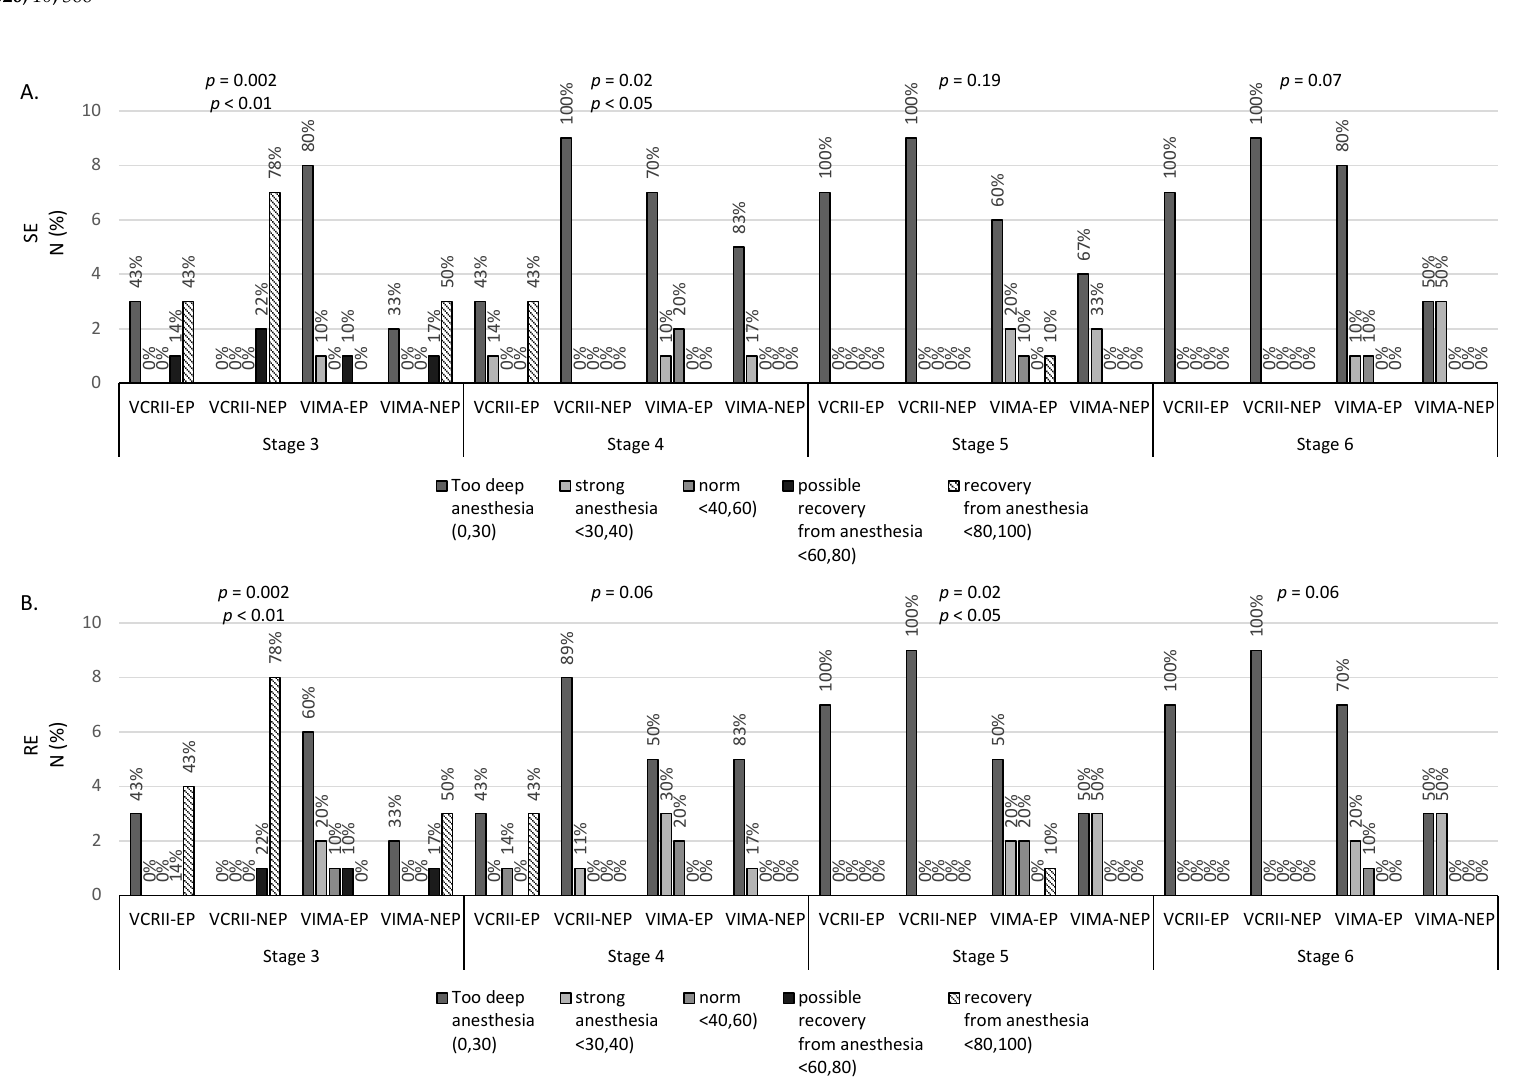
Figure 3. Number of erroneous ( A ) SE, ( B ) RE values at different stages of general anaesthesia. SE—state entropy, RE—response entropy. Results presented as numbers (percentages) for discrete variables. a , the Fisher’s Exact Test.